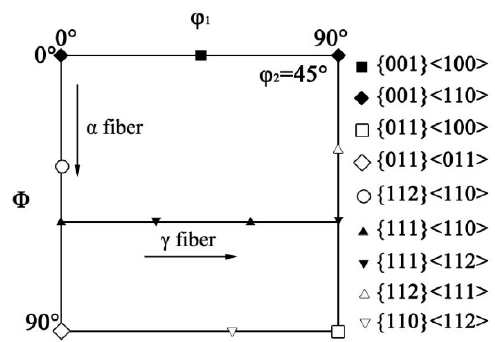
Figure 8. Ideal preferred orientations in Euler space.